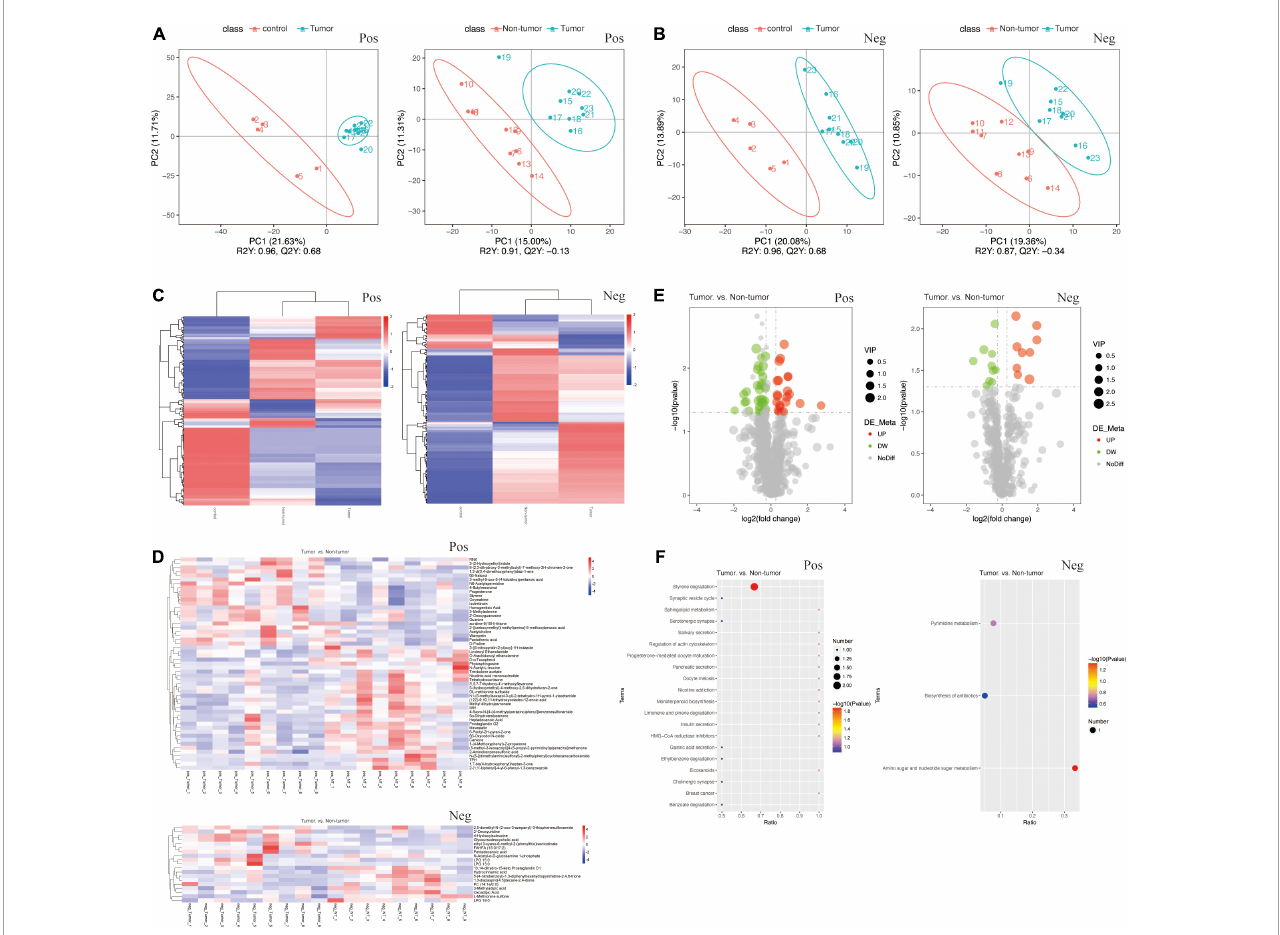
FIGURE4 Changes of the fecal metabolites in the groups. (A,B) PLS-DA of fecal samples between tumor group and control group (A) , between tumor group and non-tumor group (B) , by the positive and negative ion methods. (C) Heat maps of different fecal metabolites among three groups. (D) Heat maps of different metabolites in each fecal samples between tumor group and non-tumor group. (E) Volcano Plots indicating the variation of fecal metabolites between the two groups. (F) KEGG pathway analysis of metabolism between the two